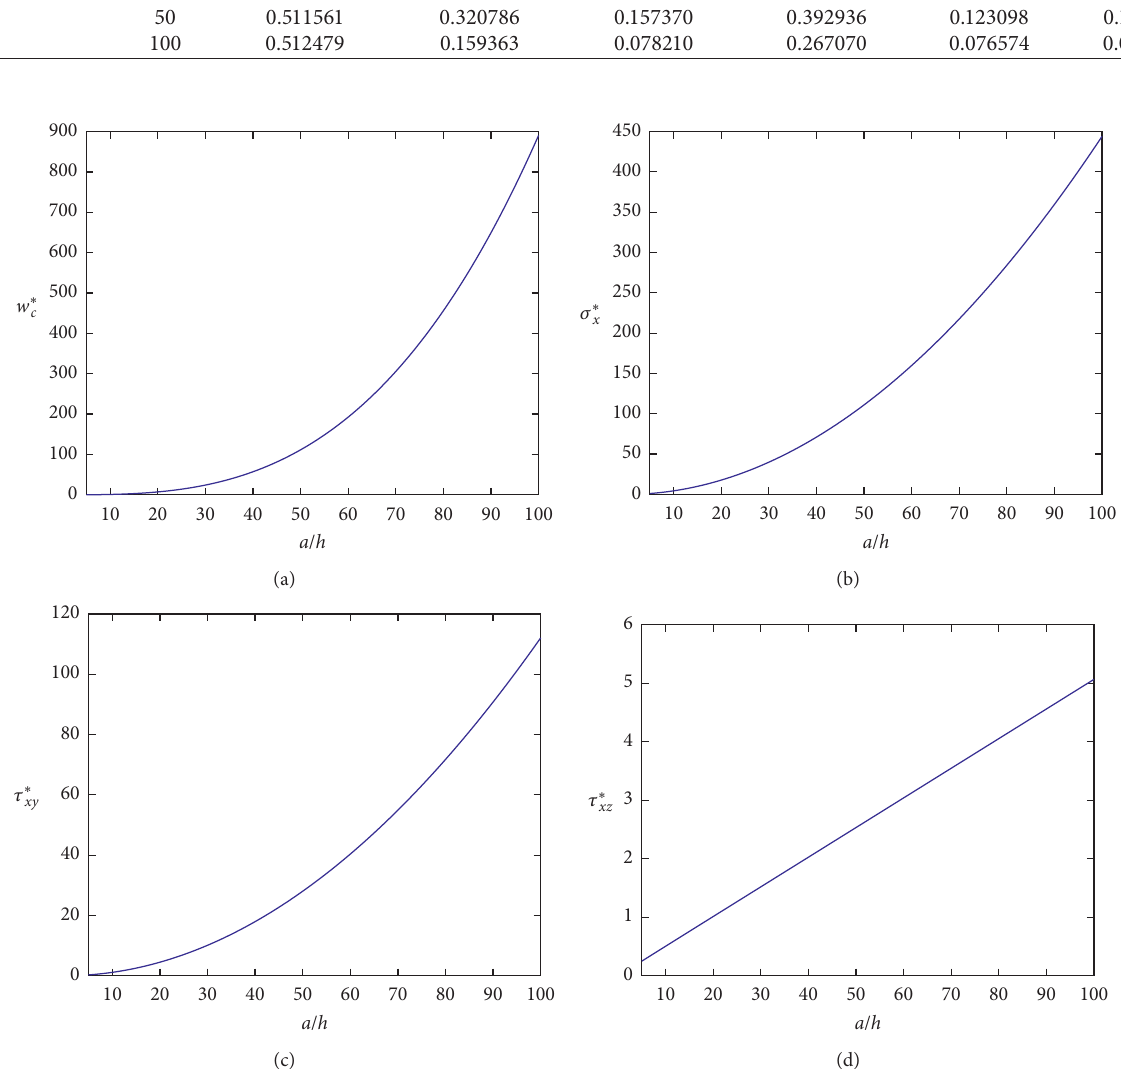
Figure 4: The variation of the deflection and stresses as the functions of side-to-thickness ratio without elastic foundation ( K